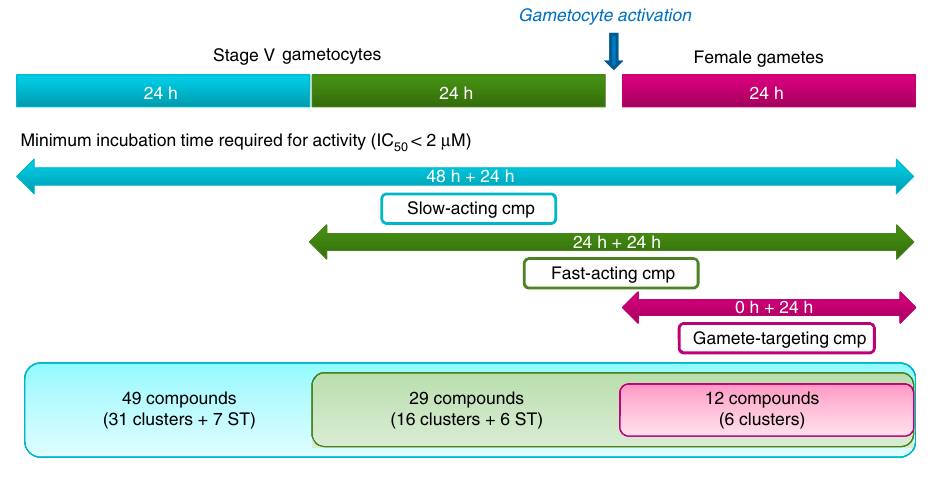
Figure 4 | Diversity of biological profiles determined by use of different incubation times in the Pf FGAA. Stage V gametocytes were exposed to the 90 selected compounds for 24 or 48h to determine the drug inhibitory speed of action. In addition, compounds were added after triggering gametocyte activation to evaluate their activity in female gametes. The figure shows the number of compounds and chemical diversity classified under each category, that is, slow-acting, fast-acting or gamete-targeting